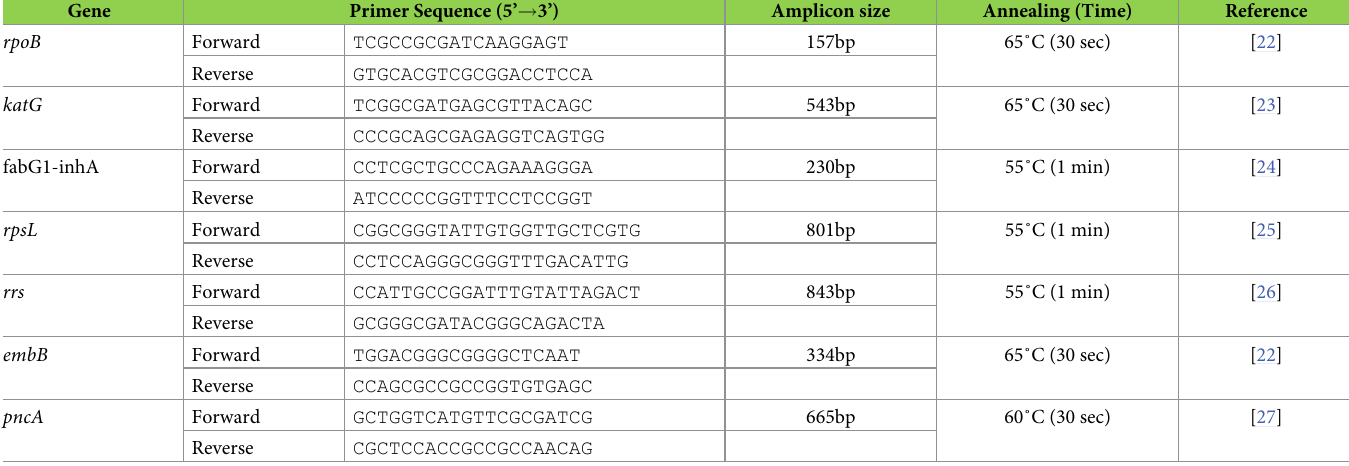
Table 1. Primers that were used for PCR amplification and sequence of drug target genes for analysis of the mutation in MTBC strains. Gene Primer Sequence (5’ !